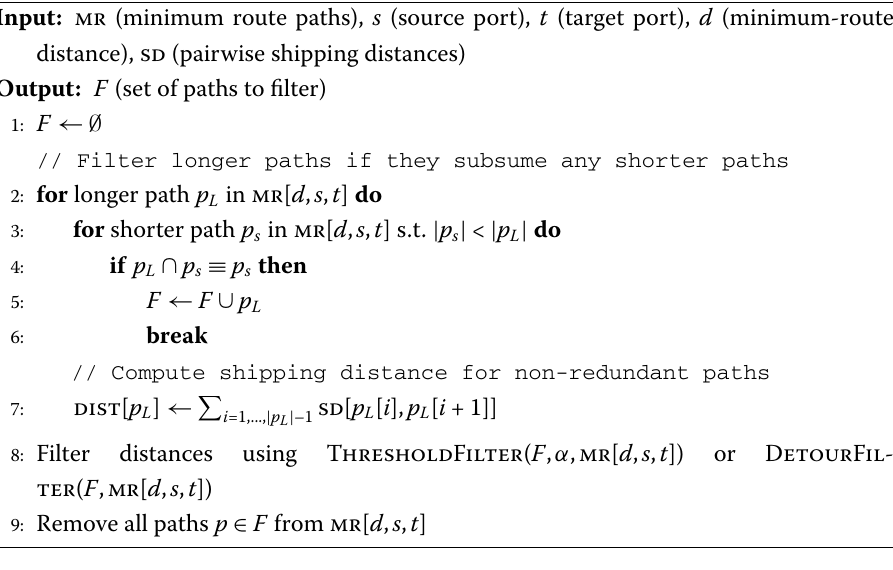
Algorithm 2 FilterPaths(mr, s , t , d , α ,